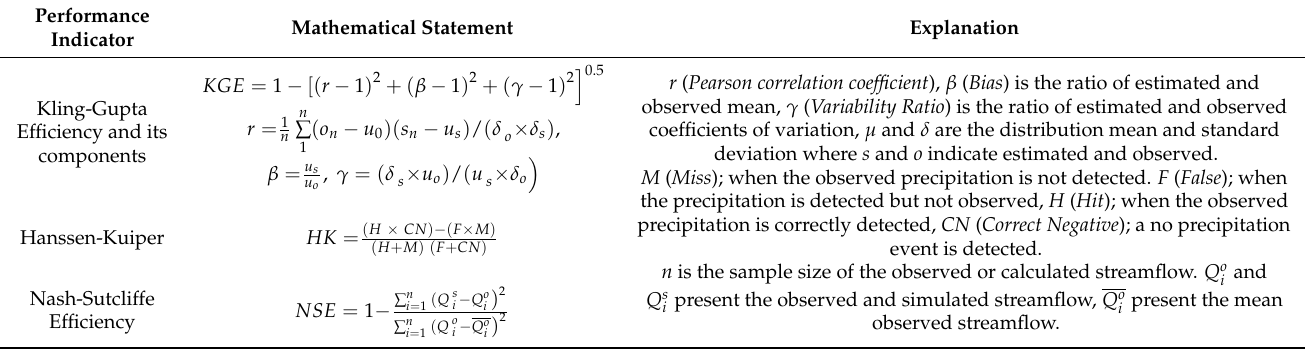
Table 2. Properties of performance indices for evaluation of GPDs.